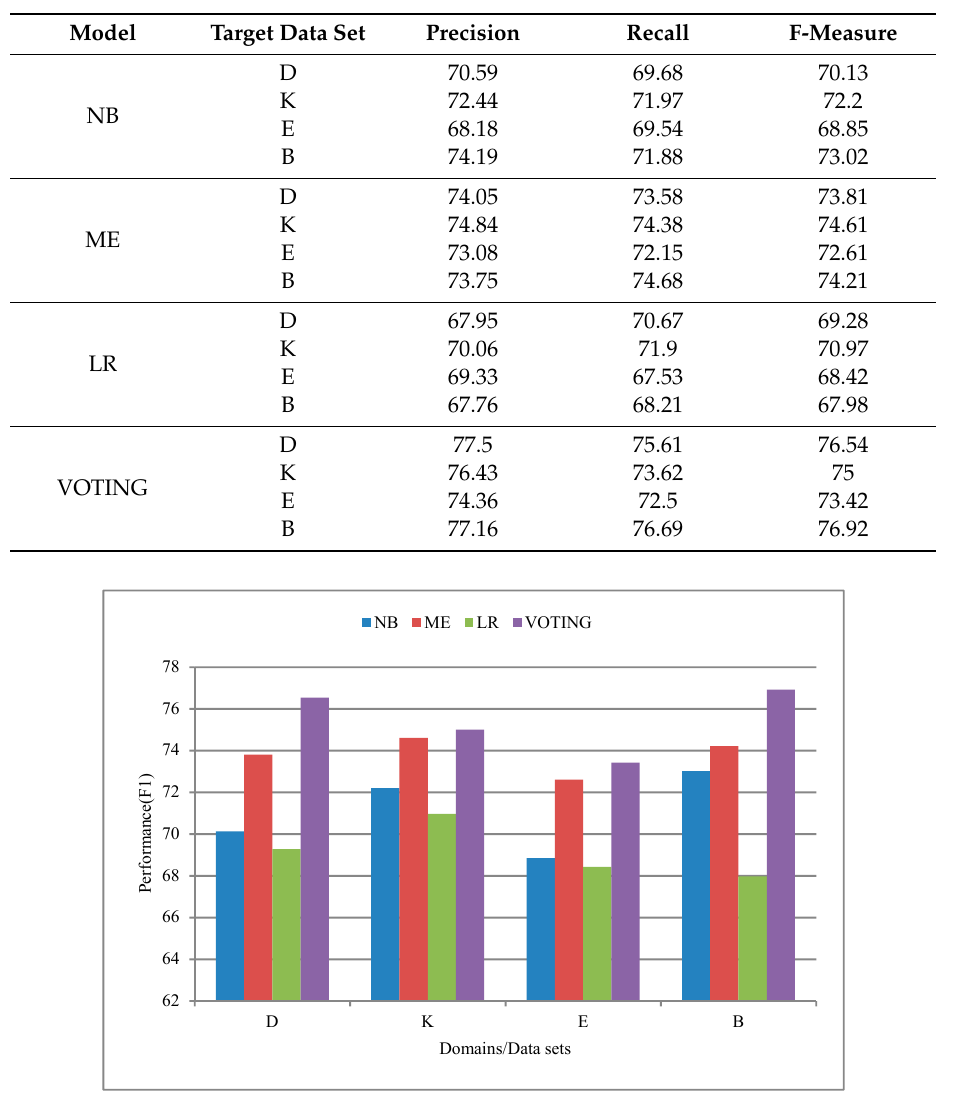
Figure 2. Performance of baseline supervised learning models on Books B, DVDs D, Electronics E, and Kitchen K domains. Table 3. Performance of Baseline Semi-Supervised Learning Model.